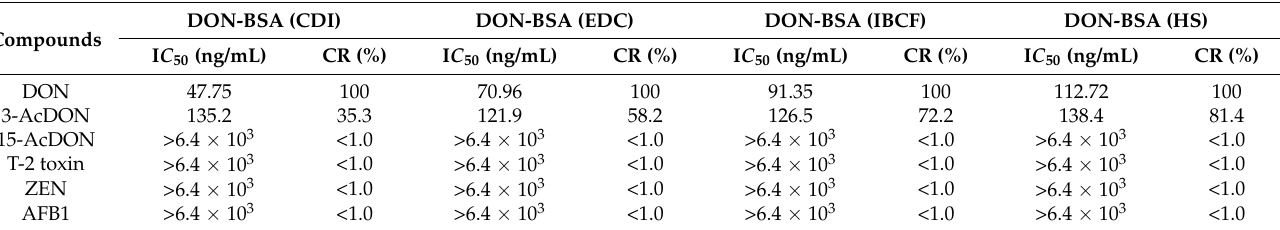
Table 3. The specific identification of